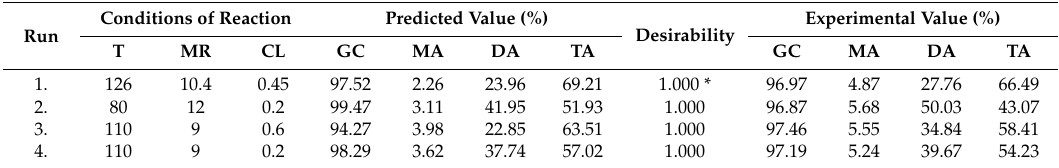
Table 3. The predicted and the validation of results of the numerical optimization.